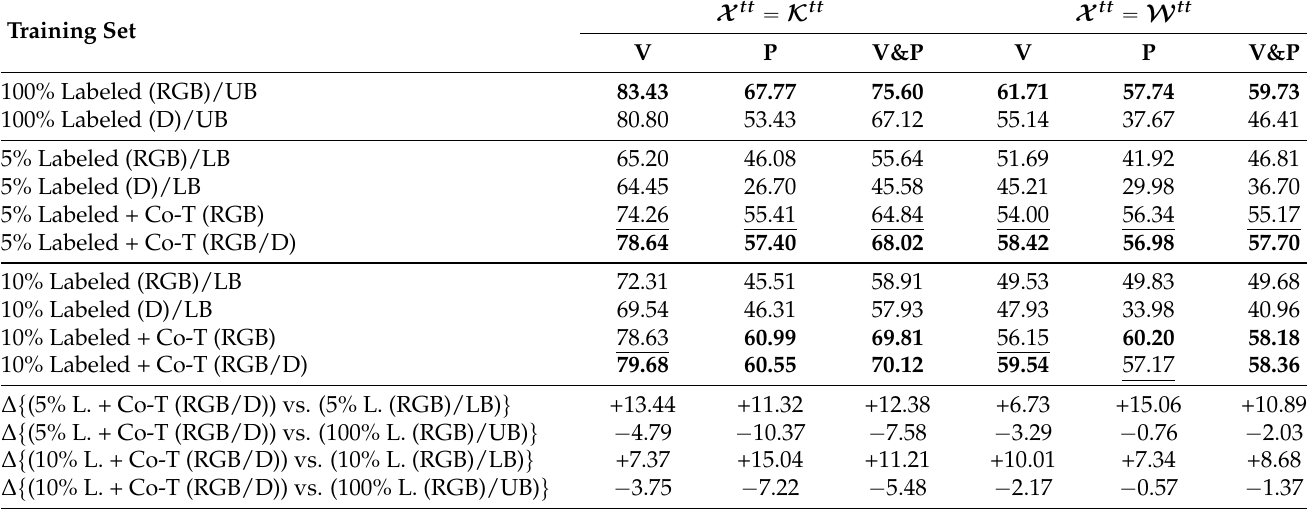
Table 4. SSL (co-training) results on vehicle (V) and pedestrian (P) detection, reporting mAP. From a training set X tr P t K tr , W tr u , we preserve the labeling information for a randomly chosen p % of its images, while it is ignored for the rest. We report results for p = 100 (all labels are used), p = 5 and p = 10. If X tt “ K tt , then X tr “ K tr ; analogously, when X tt “ W tt , then X tr “ W tr , i.e., there is no domain shift in these experiments. Co-T (RGB) and Co-T (RGB/D) stand for single and multi modal co-training, respectively. UP and LB stand for upper bound and lower bound, respectively. Bold results indicate best performing within the block, where blocks are delimited by horizontal lines. Second best is underlined, but if the difference with the best is below 0.5 points, we use bold too. ∆ t φ F of φ F . 2